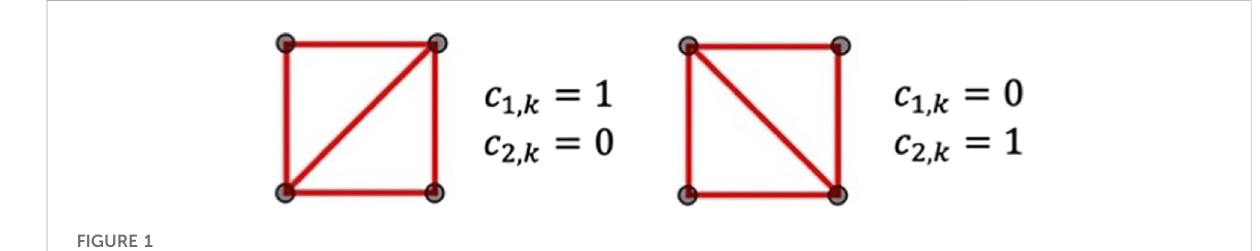
FIGURE 1 Bracing directions in the grid cell k and corresponding values of c 1 , k and c 2 ,